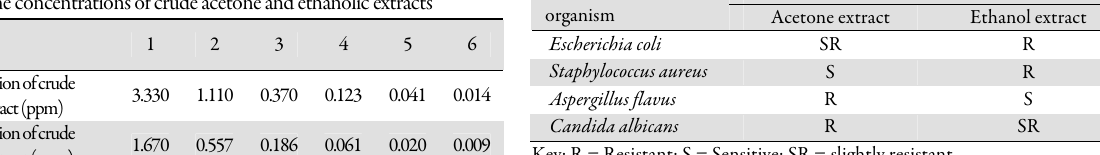
Key: R = Resistant; S = Sensitive; SR = slightly